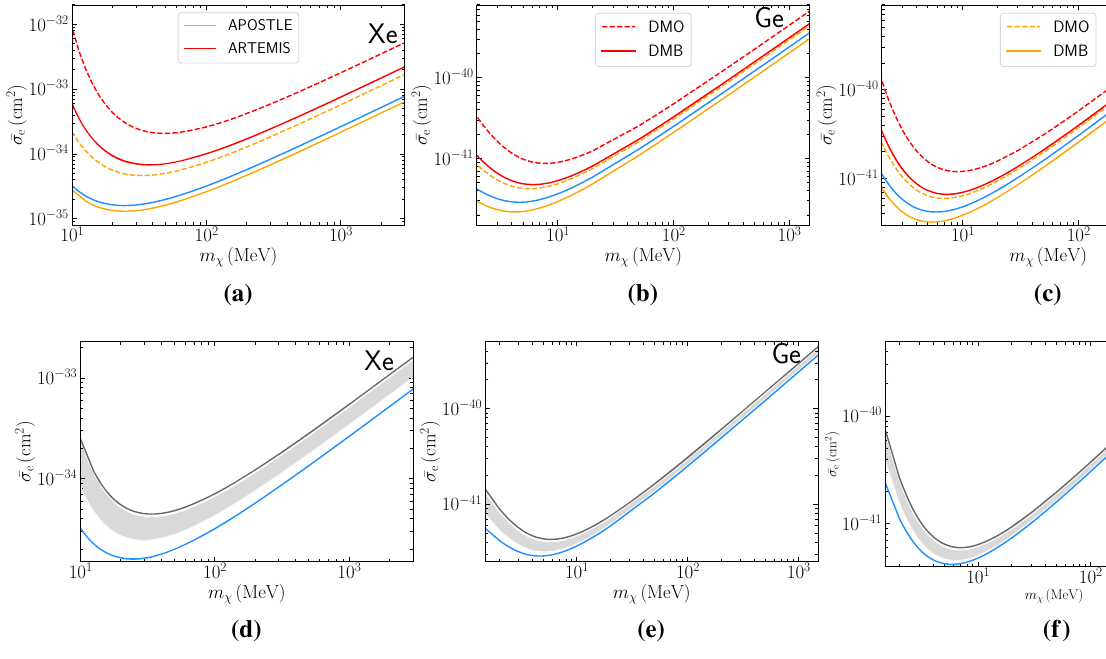
Fig. 14 Same as Fig. 13 but for F DM ∝ q − 2